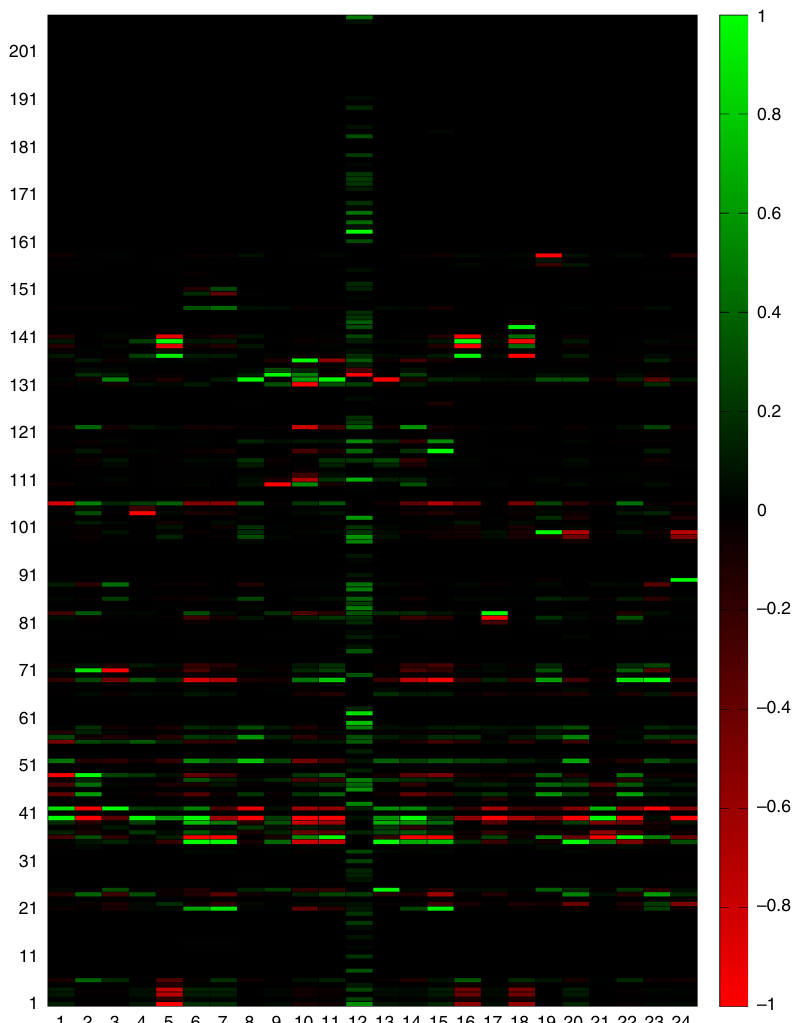
Fig. 5 Dynamic control of 24 different metabolic functions. The maximal activity of each enzyme model was reduced by 10% and the resulting changes of the diurnal time-courses of 24 selected metabolic functions were quanti fi ed by means of the time-averaged response coef fi cient (de fi ned by equation (6) in Methods). To quantify the relative impact of individual enzymes, the maximal positive and negative values means of the time-averaged response coef fi cients (Supplementary Data 2) were normalized to the range [ – 1, + 1]. Numbering of metabolic functions: (1) glucose exchange rate, (2) lactate exchange rate, (3) pyruvate exchange rate, (4) glycerol exchange rate, (5) fatty acid uptake rate, (6) acetoacetate secretion rate, (7) β -hydroxybuterate secretion rate, (8) oxygen uptake rate, (9) ammonia uptake rate, (10) glutamine exchange rate, (11) glutamate exchange rate, (12) serine exchange rate, (13) alanine exchange rate (14) urea secretion rate; (15) acetate exchange rate, (16) VLDL secretion rate, (17) glycogen storage, (18) cellular triglyceride concentration, (19) cholesterol synthesis rate, (20) fatty acid synthesis rate, (21) mitochondrial membrane potential, (22) ATP/ADP